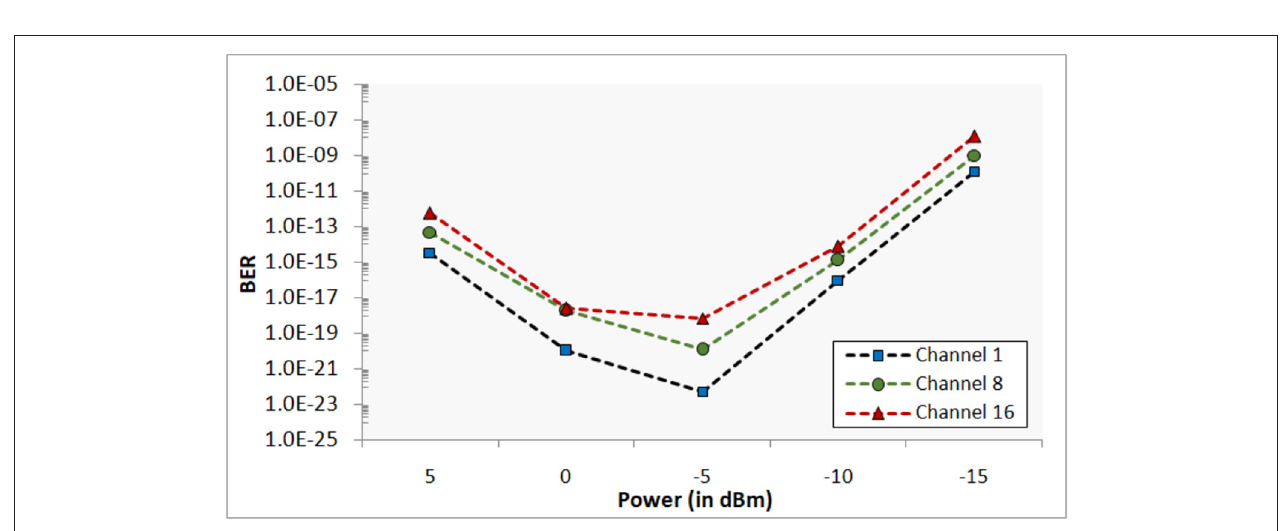
FIGURE 7 | Variation of BER with power at channel spacing of 100